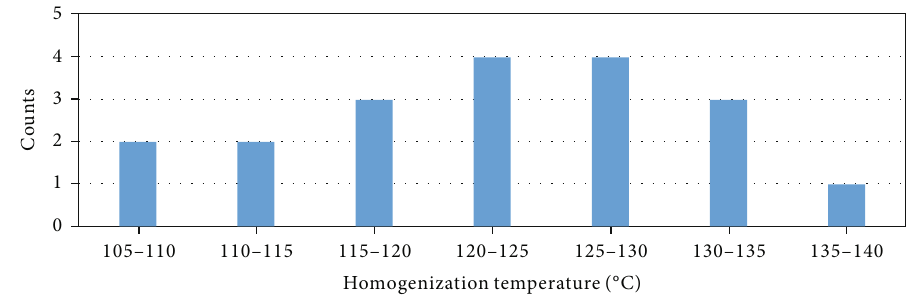
Figure 8: Histogram of homogenization temperatures of the fl uid inclusions within the Longtan tight sandstones in west